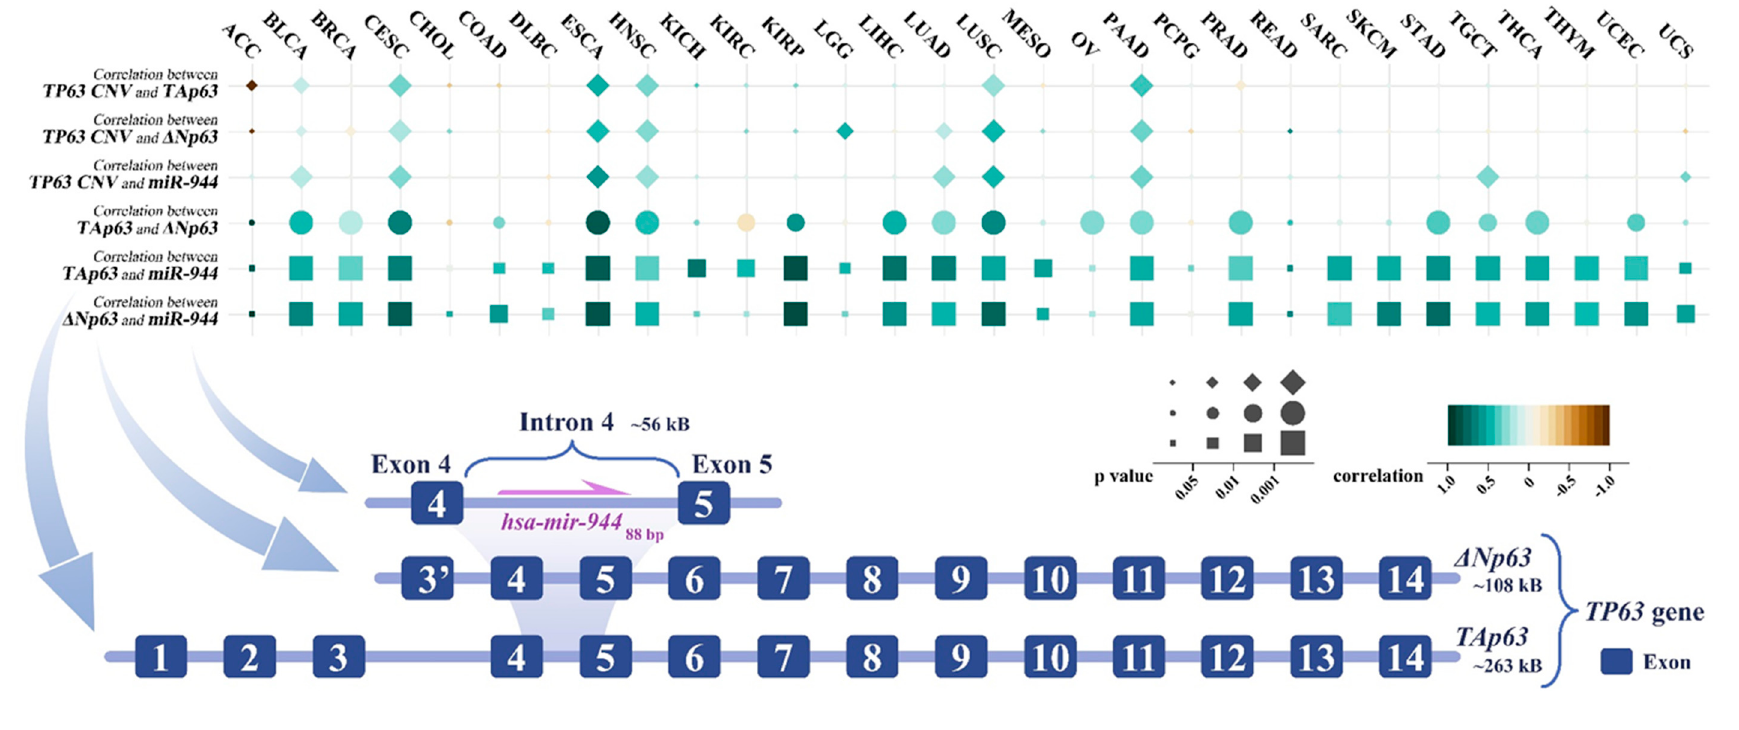
Figure 2. The correlation of miR-944 with TP63 CNV, TAp63, and ∆ Np63. The figure indicates the position of hsa-mir-944 in the TP63 gene and shows the correlation of miR-944 with TP63 CNV and the expression of TAp63 and ∆ Np63. ACC, adrenocortical carcinoma; BLCA, bladder urothelial carcinoma; BRCA, breast invasive carcinoma; CESC, cervical squamous cell carcinoma and endocervical adenocarcinoma; CHOL, cholangiocarcinoma; COAD, colon adenocarcinoma; DLBC, lymphoid neoplasm diffuse large B-cell lymphoma; ESCA, esophageal carcinoma; HNSC, head and neck squamous cell carcinoma; KICH, kidney chromophobe; KIRC, kidney renal clear cell carcinoma; KIRP, kidney renal papillary cell carcinoma; LGG, brain lower grade glioma; LIHC, liver hepatocellular carcinoma; LUAD, lung adenocarcinoma; LUSC, lung squamous cell carcinoma; MESO, mesothelioma; OV, ovarian serous cystadenocarcinoma; PAAD, pancreatic adenocarcinoma; PCPG, pheochromocytoma and paraganglioma; PRAD, prostate adenocarcinoma; READ, rectum adenocarcinoma; SARC, sarcoma; STAD, stomach adenocarcinoma; SKCM, skin cutaneous melanoma; TGCT, testicular germ cell tumor; THCA, thyroid carcinoma; THYM, thymoma; UCEC, uterine corpus endometrial carcinoma; UCS, uterine carcinosarcoma.